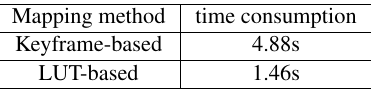
Figure 10. The result of our method Mapping method